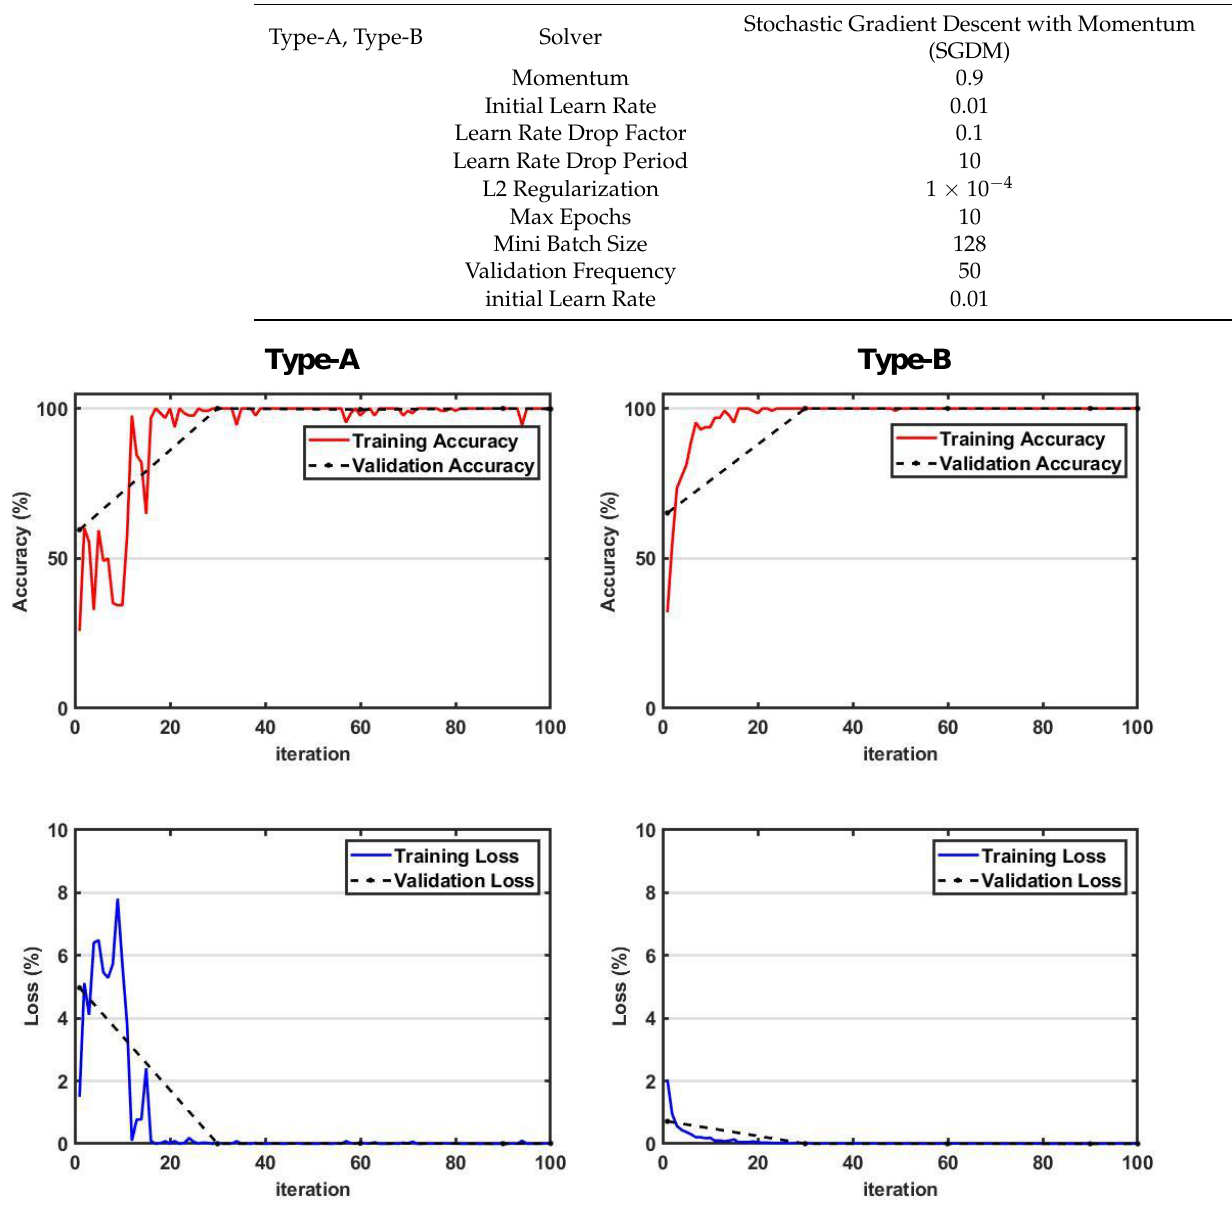
Table 3. Training options for convolutional neural network.